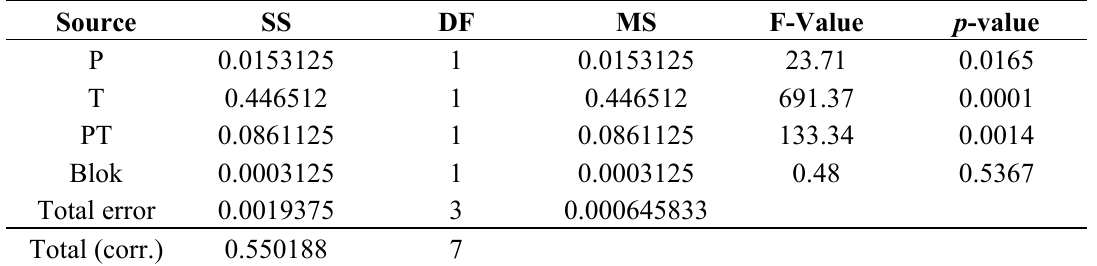
Table 1. ANOVA for the effect of pressure (P) and temperature (T) on anthocyanin contents.